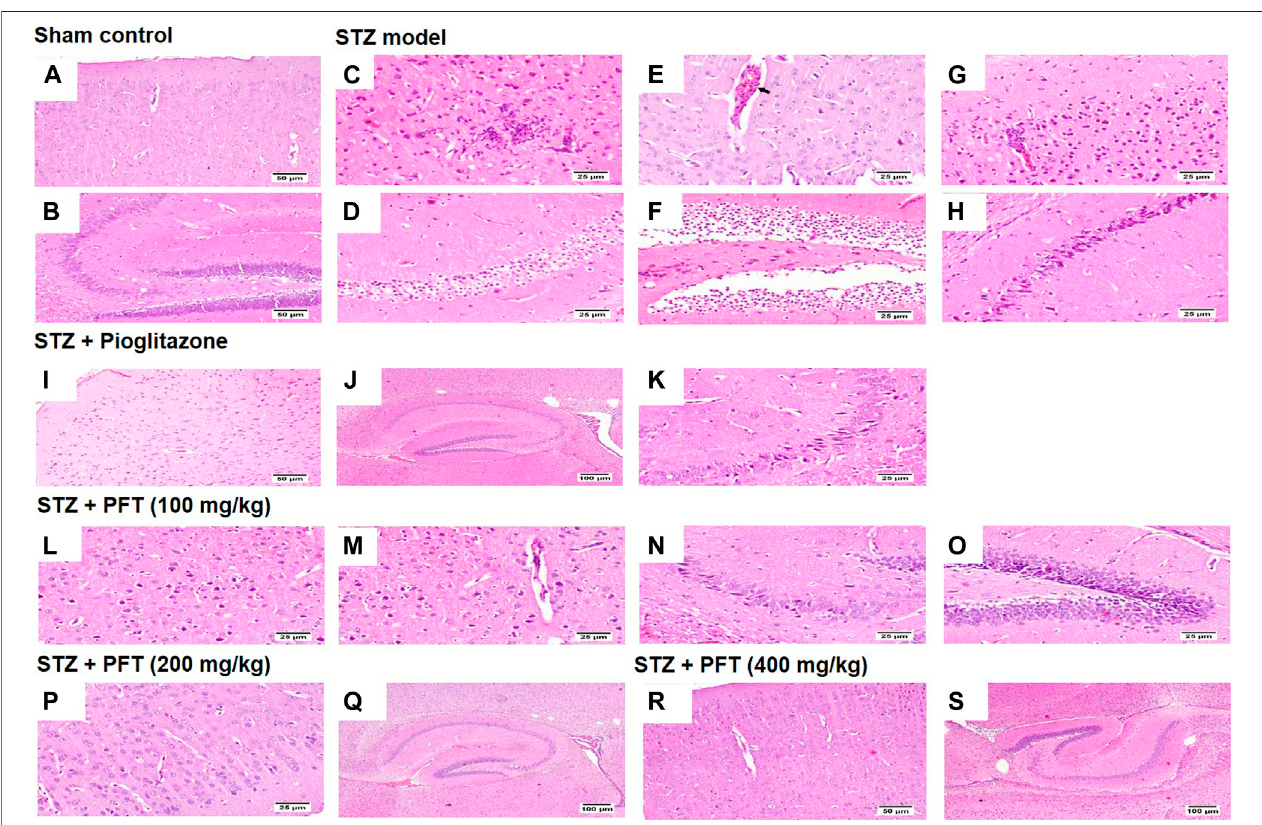
FIGURE 7 | Histological sections of H and E staining in the cerebral cortex and hippocampus of the experimental groups; where sham control mouse showed normal histology of neurons in the cerebral cortex (A) , and the hippocampus (B) . STZ model group brain showed area of malacia associated with focal gliosis and necrosis (C) , thickened blood vessel wall(arrow) (E) , and perivascularlymphocyticcuf fi ng withsurrounding dark degenerated neurons inthe cerebral cortex (G) ,beside neuronaledema ofCA1 and CA2 regions (D) , as well asneuronaledema of DG region (F) and shrunken dark degenerated neuron in CA3 of the hippocampus (H) . Mice receiving pioglitazone showed apparently normal neurons in the cerebral cortex (I) and apparently normal nerve cells in most of the hippocampus regions (J) with few scattered dark degenerated neurons in CA3 and CA4 regions (K) . PFT (100 mg/kg) brain revealed variable number of dark degenerated neurons accompanied by gliosisinthecerebralcortex (L) alongwithneuronaldegenerationandneuronophagiawithmildthickeningofbloodvesselwall (M) ,besides,darkdegeneratedneuronsin theCA4 region (N) ,and intheDGregionofthehippocampus (O) .Brain ofPFT(200 mg/kg)apparentlynormalneurons inthecerebralcortex (P) , andapparentlynormal neurons in the hippocampus with few scattered neurons in CA4 and DG (Q) . Brain of PFT (400 mg/kg) displayed apparently normal neurons cerebral cortex (R) , and apparently normal neurons in the hippocampus (S) .